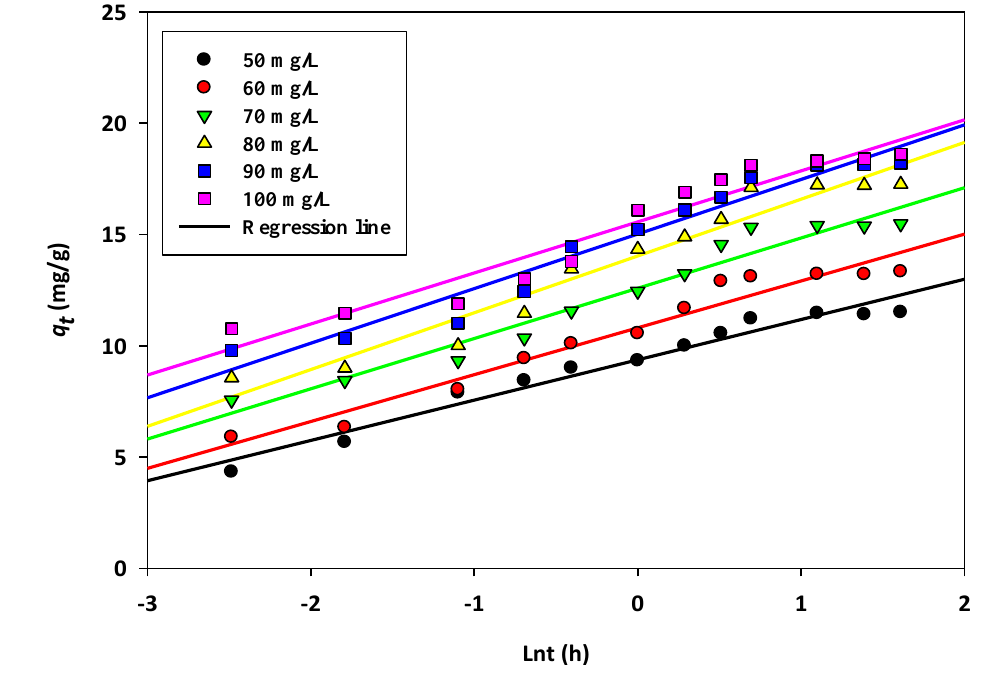
Figure 5. Elovich kinetics of copper, Cu(II) cations sorption onto activated biochar.